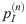
The layer active probability (pI(n)) as function of layer I is defined as smile curve.